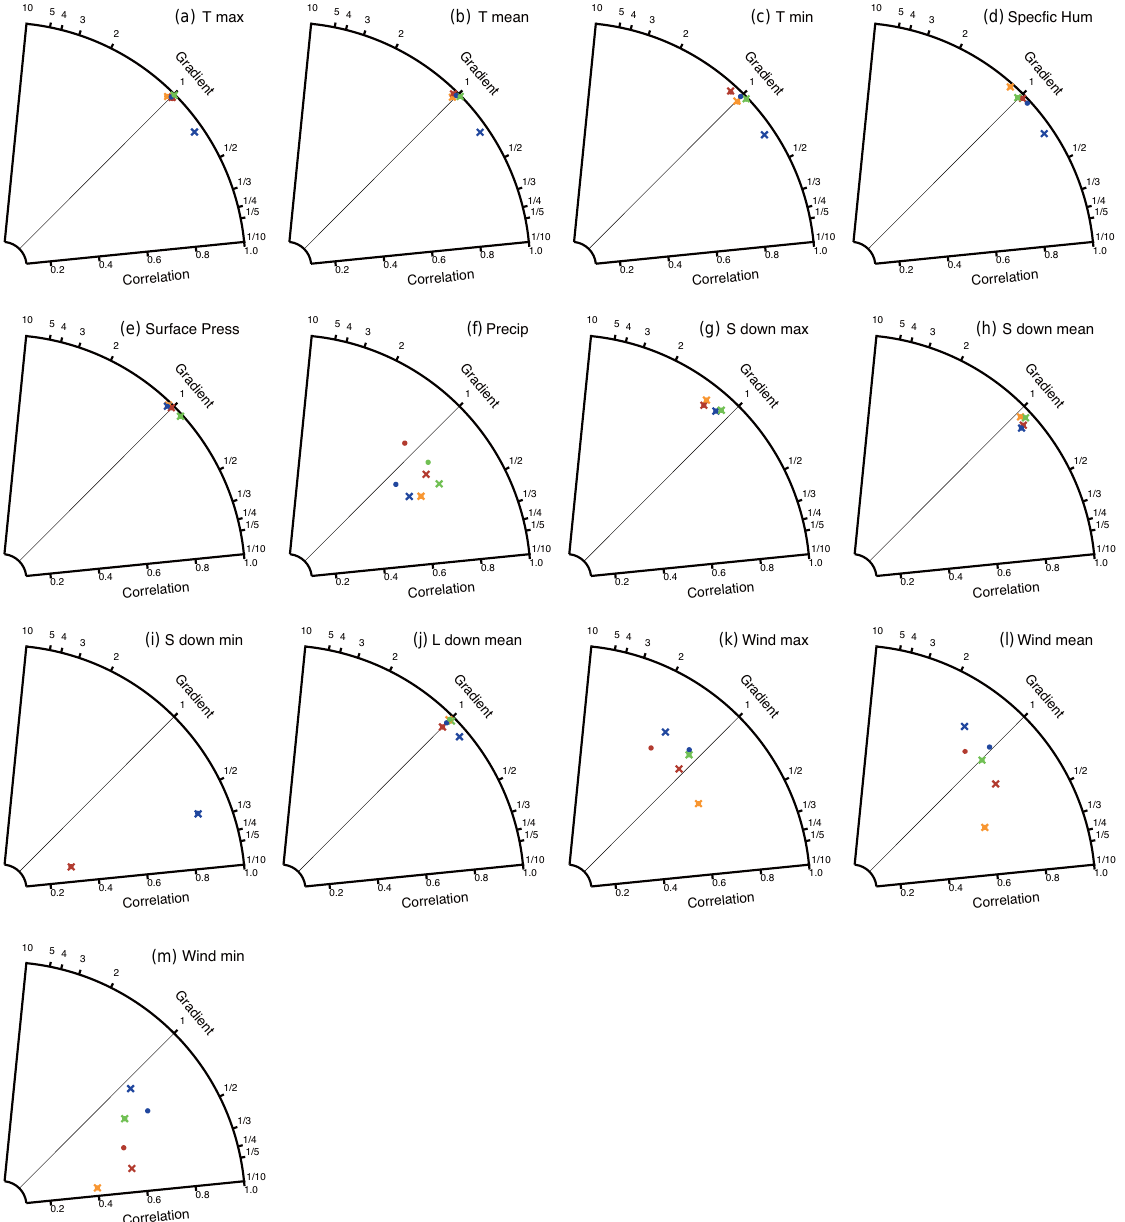
Figure 7. Correlation diagrams for GTMIP data and daily site observation data showing Pearson’s correlation coefficient and gradient of the fitted line for (a) maximum air temperature, (b) mean air temperature, (c) minimum air temperature, (d) specific humidity, (e) surface pressure, (g) maximum downward short-wave radiation, (h) mean downward short-wave radiation, (i) minimum downward short-wave radiation, (j) downward long-wave radiation, (k) maximum wind speed, (l) mean wind speed, and (m) minimum wind speed. Lv0 data are shown as crosses and Lv1 data as dots. Sites are shown by colours, i.e. Fairbanks (orange), Kevo (red), Tiksi (blue), and Yakutsk (green).